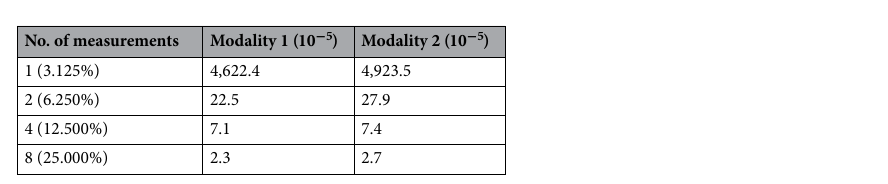
Table 5. Compressed sensing mean reconstruction error over a batch of 100 protein